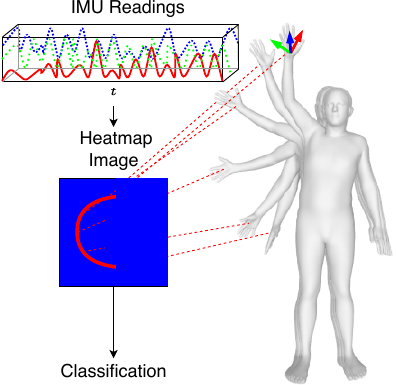
Figure 1. Transforming motion sensor data inputs into corresponding trajectories for classifying different activity